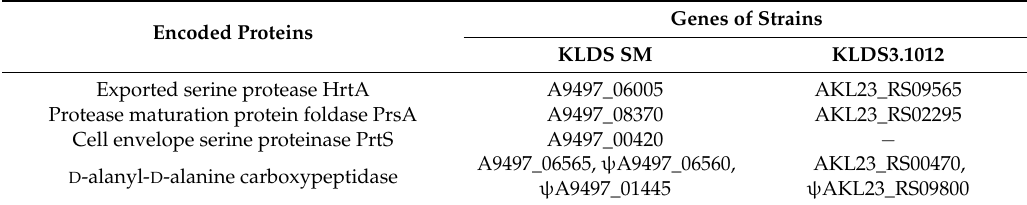
Table 1. Extracellular protease and peptidase in strains KLDS SM and KLDS3.1012.